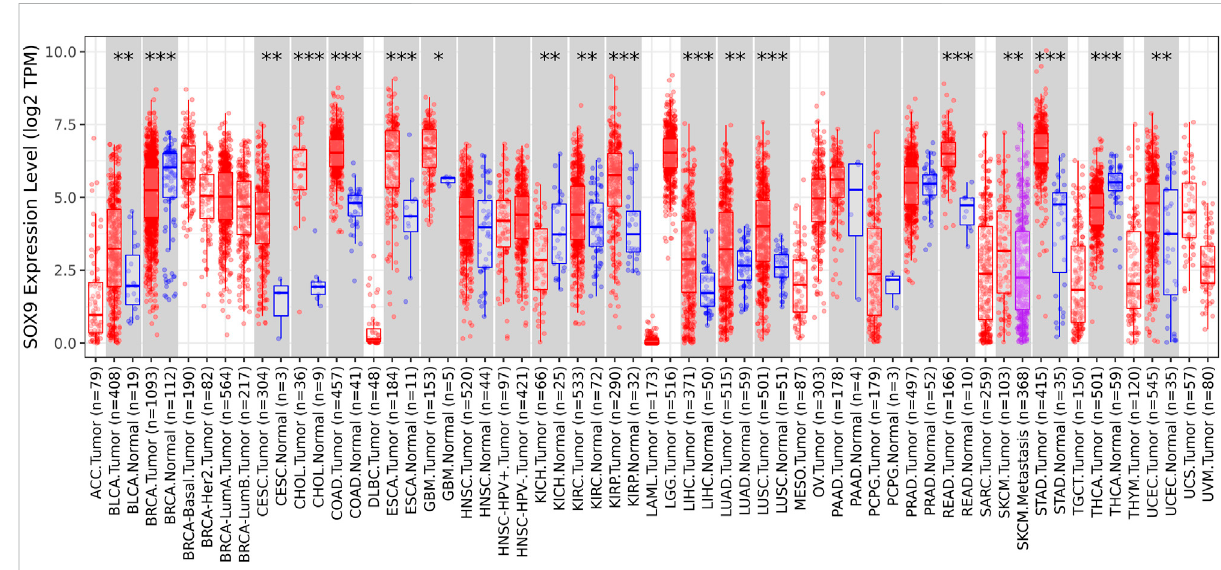
FIGURE 7 Box plot of SOX9 expression in TCGA tumors. The mRNA expression of SOX9 is higher than that of normal tissues in most TCGA tumors.